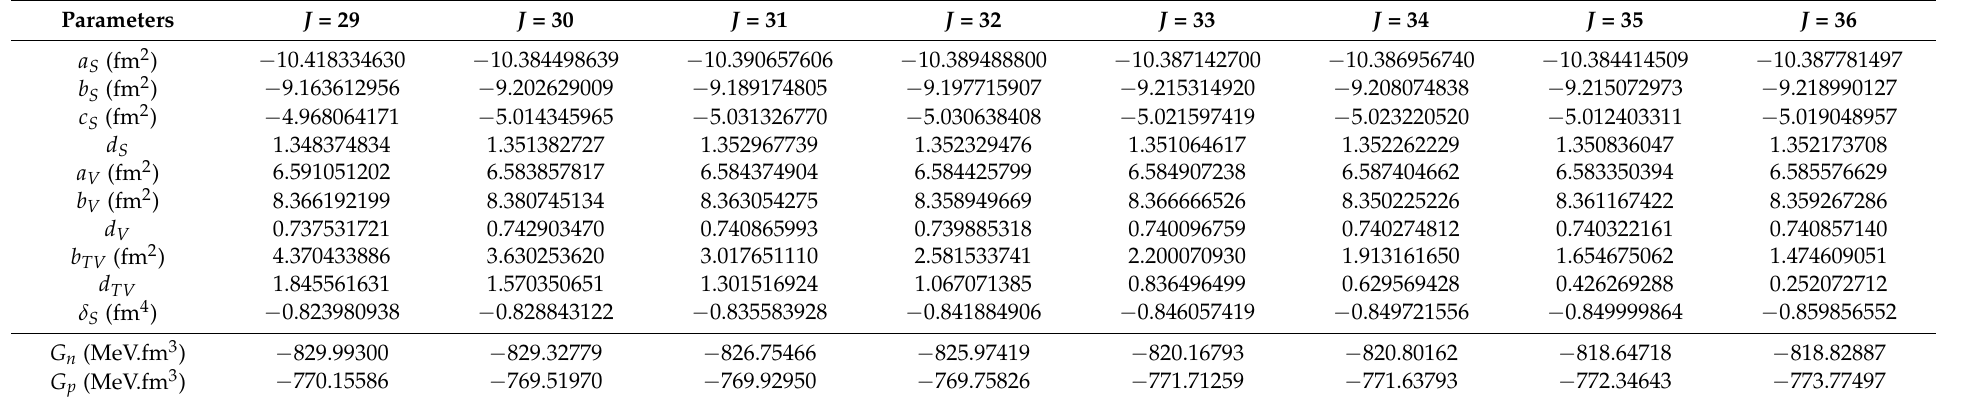
Table 2. Parameters of the DD-PC interactions with different values of the symmetry energy at the saturation J , given in units of